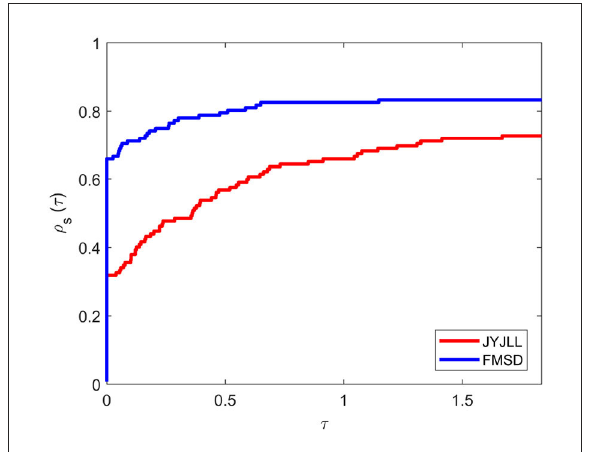
FIGURE3 Performance profiles on CPU